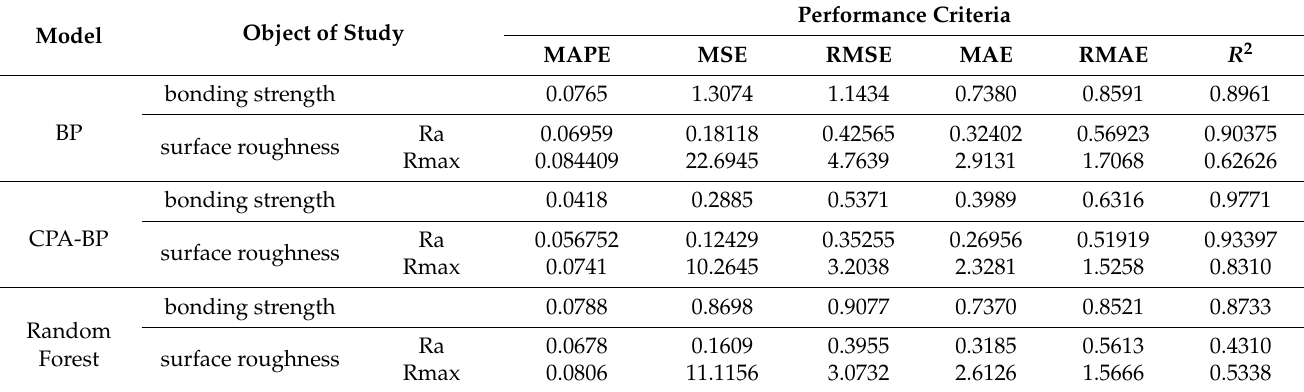
Table 10. Model error